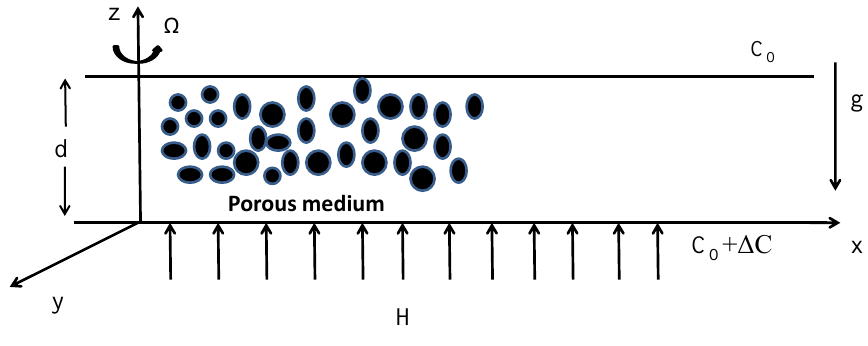
Figure 1. Physical